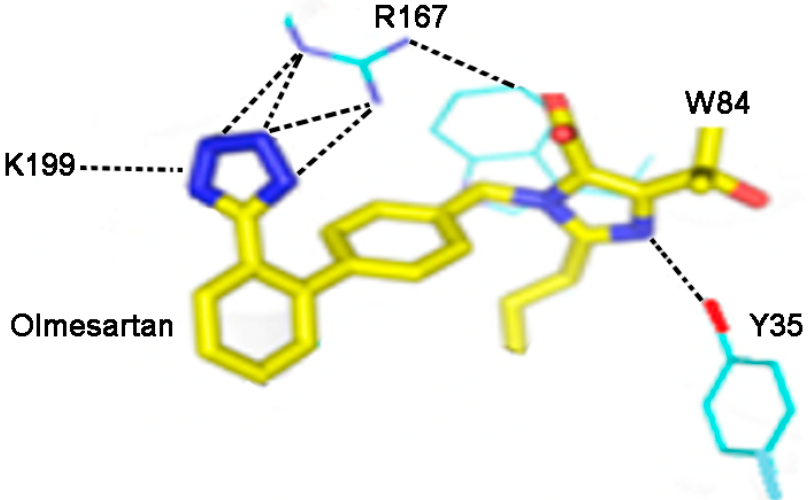
Figure 4. Interactions between receptor and olmesartan were determined from crystal structure [7]. The critical interactions of olmesartan are with R167, W84, Y35 and K199 residues of AT1R (reproduced from, Zhang et al, JBC, 290, 29127-29139, 2015).